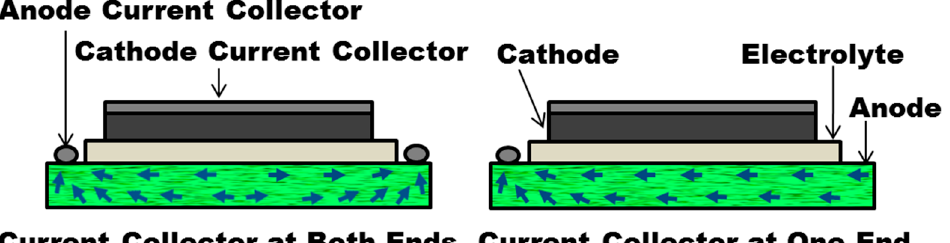
Figure 15. Current conduction pathway for current collection at both ends of the electrode versus one end (blue arrows indicate electron direction).